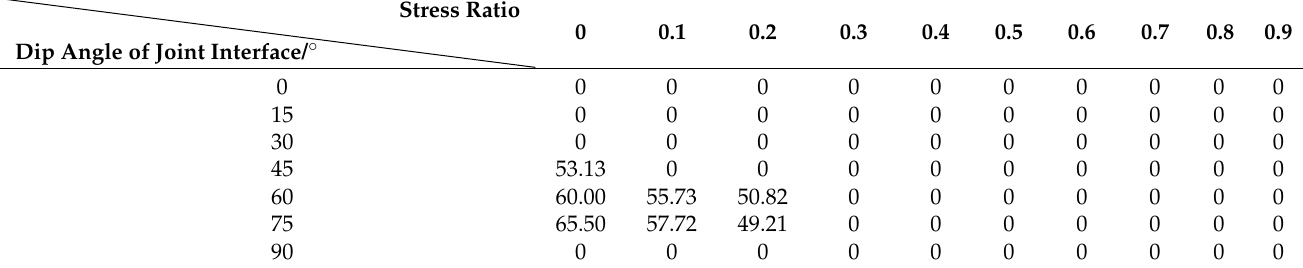
Dip Angle of Joint Interface/ ◦